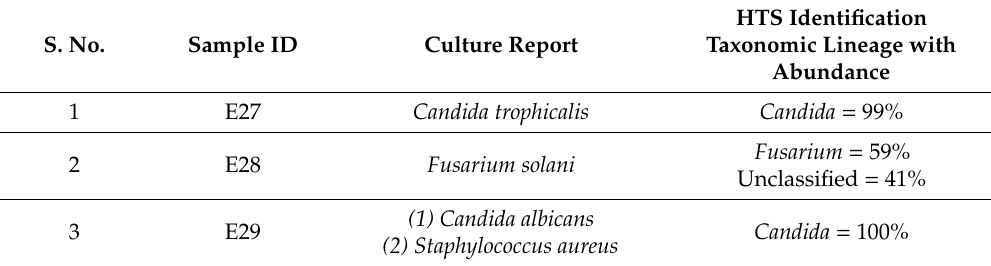
Table 3. HTS reads and taxonomic identification in fungal culture-positive